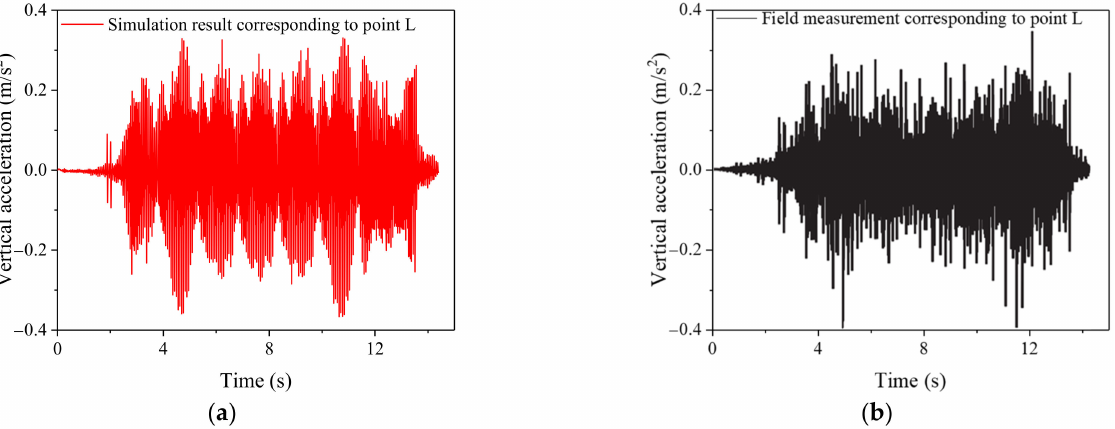
Figure 11. Vertical acceleration at point L. ( a ) Vertical acceleration from numerical model; ( b ) vertical acceleration from field test measurement Reprinted from Ref. [43]. 2019, Zhou